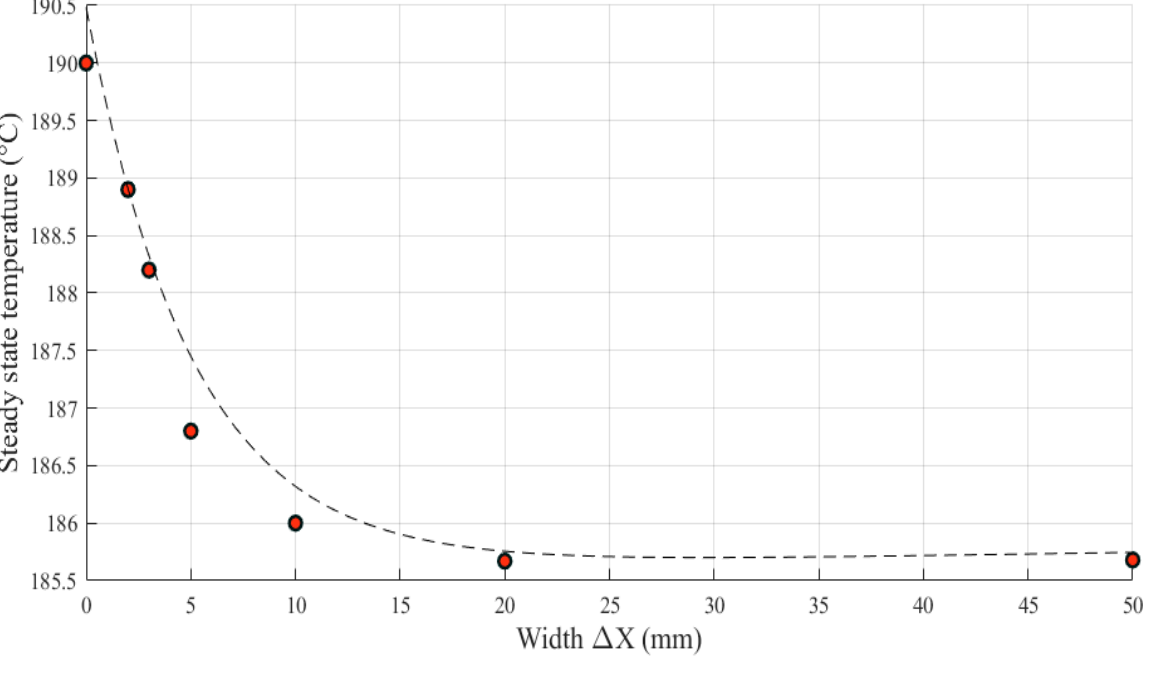
Figure 15. The regular PCB geometry with marked extension. Temperature transient of the hotspot (SP3) for different board sizes.